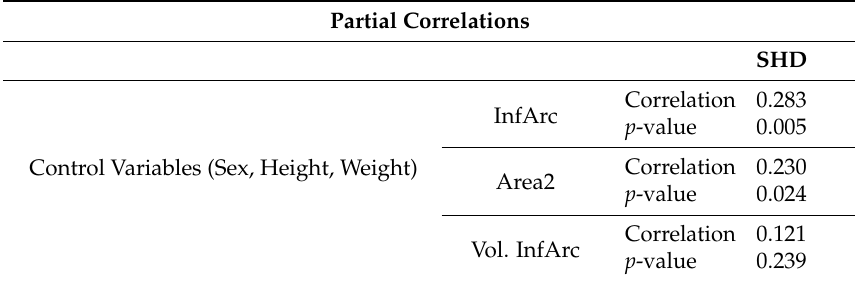
Table 3. Partial correlations between SHD and most significant measurements, controlling the variables sex, height and weight.